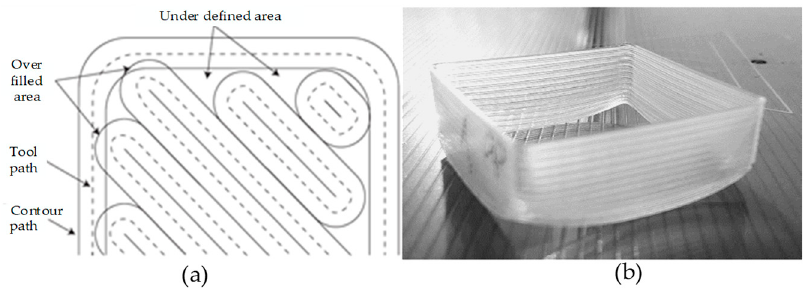
Figure 7. Illustration of PP 3D printing: ( a ) over-filled infill with contour overlap, and ( b ) shrinkage in PP printed samples. Adapted from [1], with permission from © 2015 Elsevier.